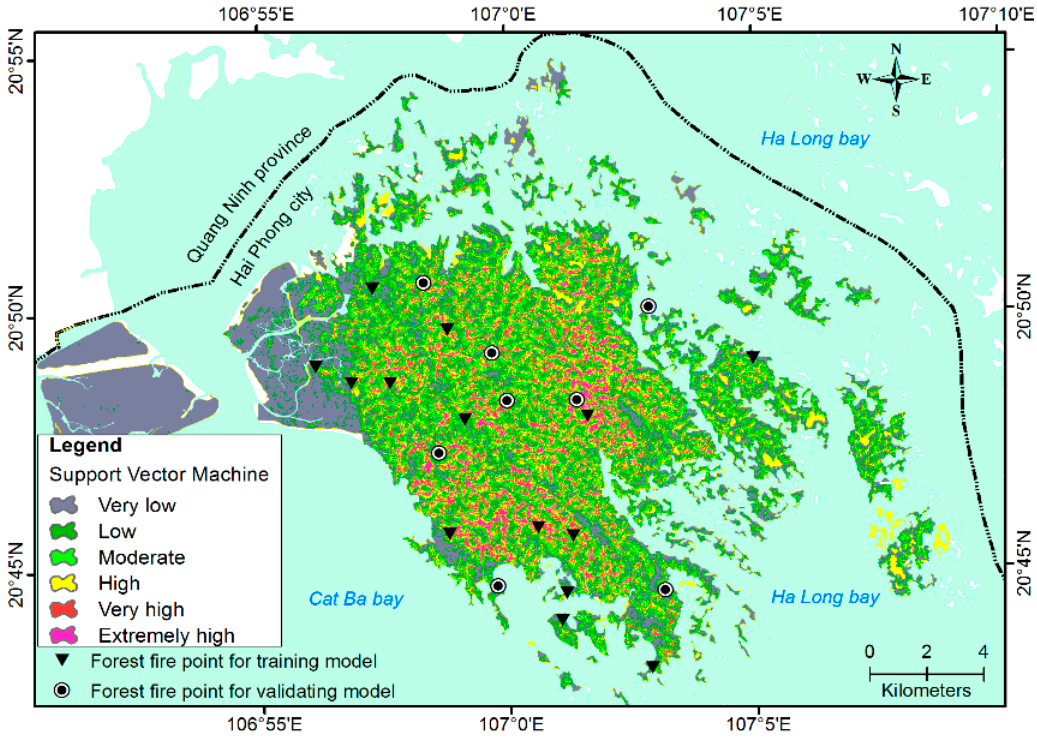
Figure 5. Forest fire susceptibility map for Cat Ba National Park area, Hai Phong City (Vietnam) using the Support Vector Machine model.